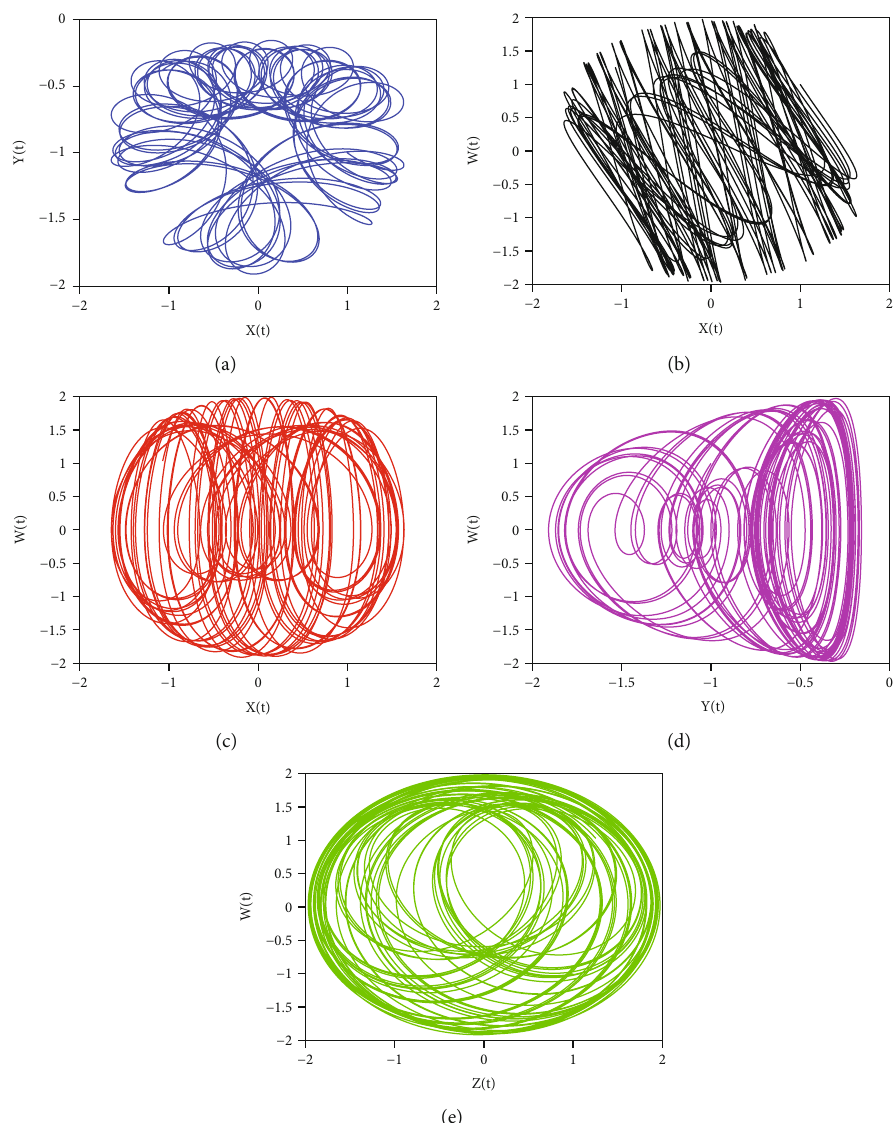
Figure 10: The behavior of di ff erent state variables of system 2 with fractional order ϖ = 1 and the parameters are considered as m = n = 5